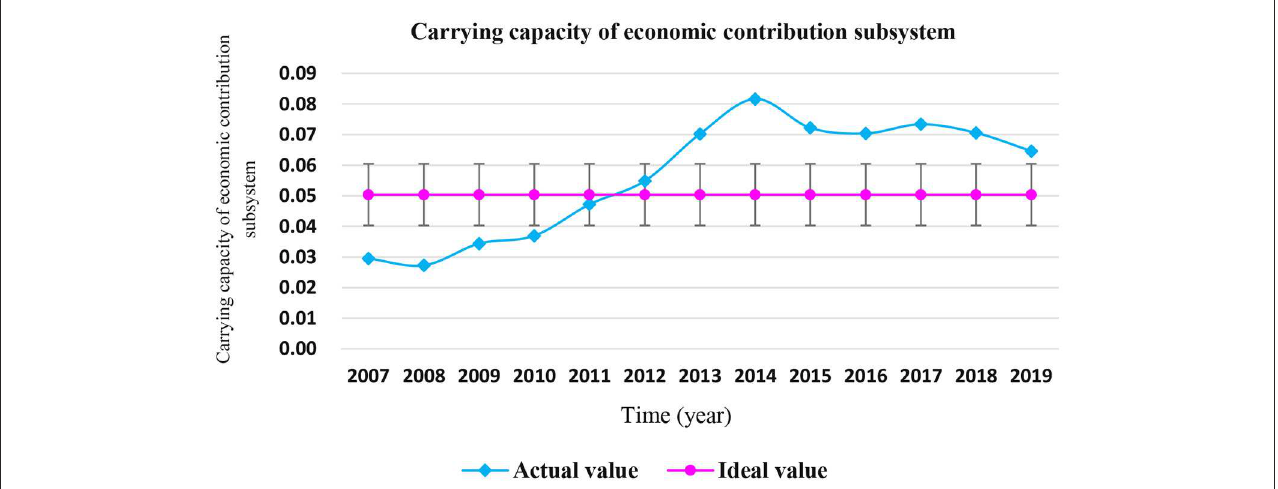
FIGURE4 Carrying status of coastal economic contribution subsystem in Shandong Province from 2007 to 2019.